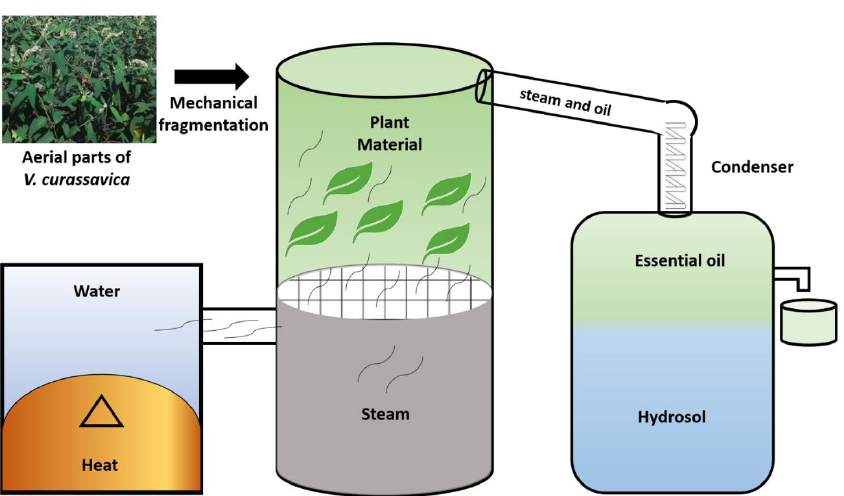
Figure 2. Representative diagram of essential oil extraction process of V. curassavica on an industrial scale.